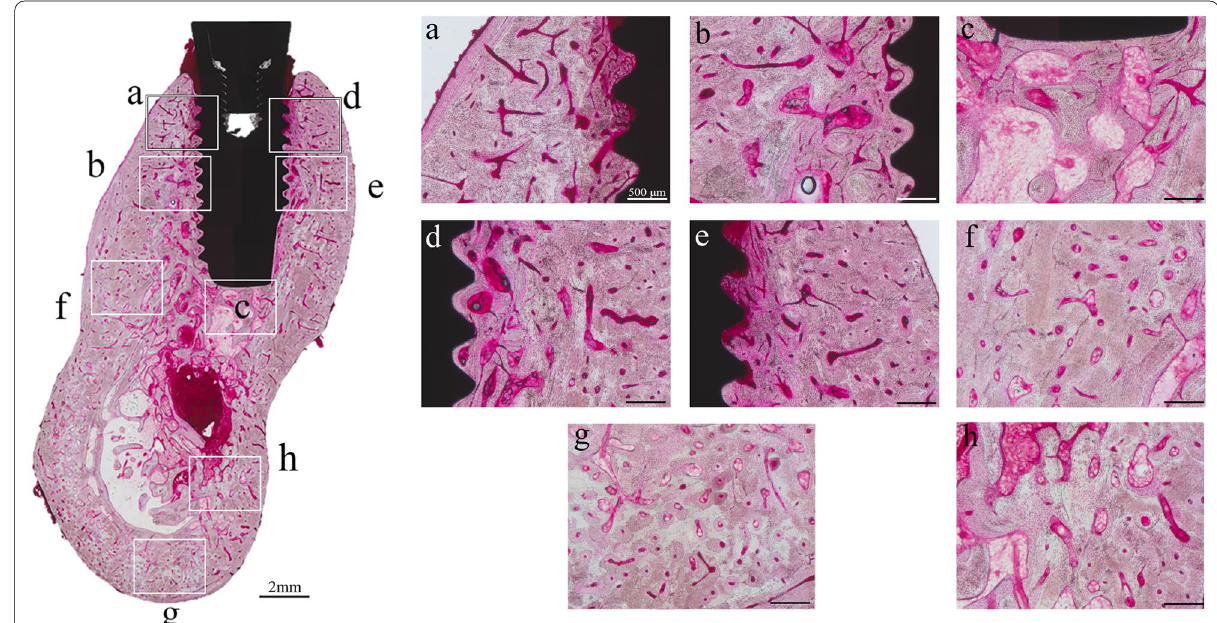
Fig. 2 Bulk staining images of peri-implant jaw bone at each measurement location. Rich canals for blood vessels in the vicinity of the implant body run in various directions. In the cortical bone at the base of the mandible, but most osteons are oriented mesiodistally. Osteons have been generated in large quantities in areas that would normally consist of cancellous bone around the